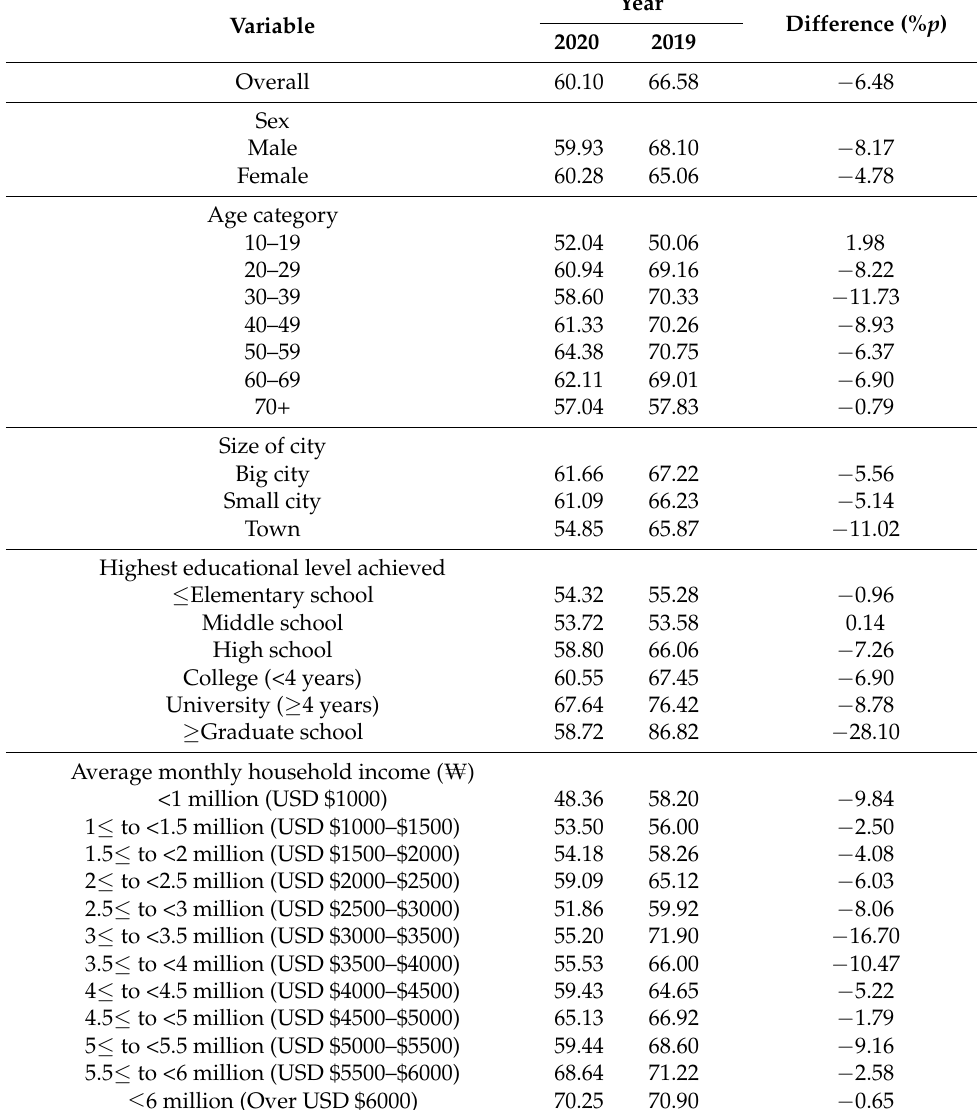
Table 2. Rate of regular participation in sports activities by year (total, unit: %, % p